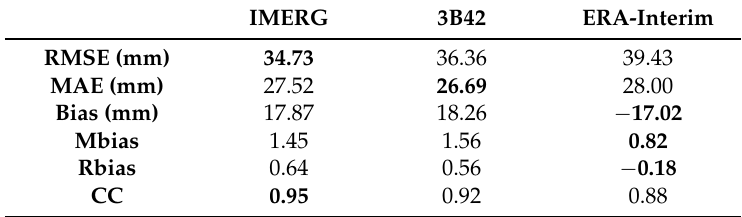
Table 14. Statistical indices of seasonal precipitation in Kermanshah area.